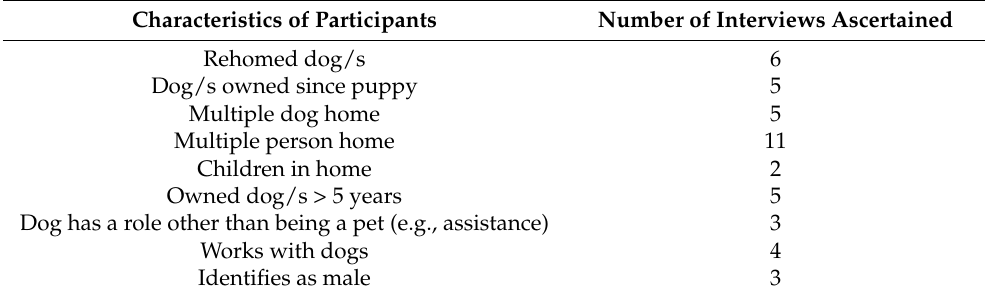
Table 3. Selected demographic characteristics of the 12 semi-structured interview participants. Characteristics overlapped so that the same people were sometimes representing multiple categories. Characteristics of Participants